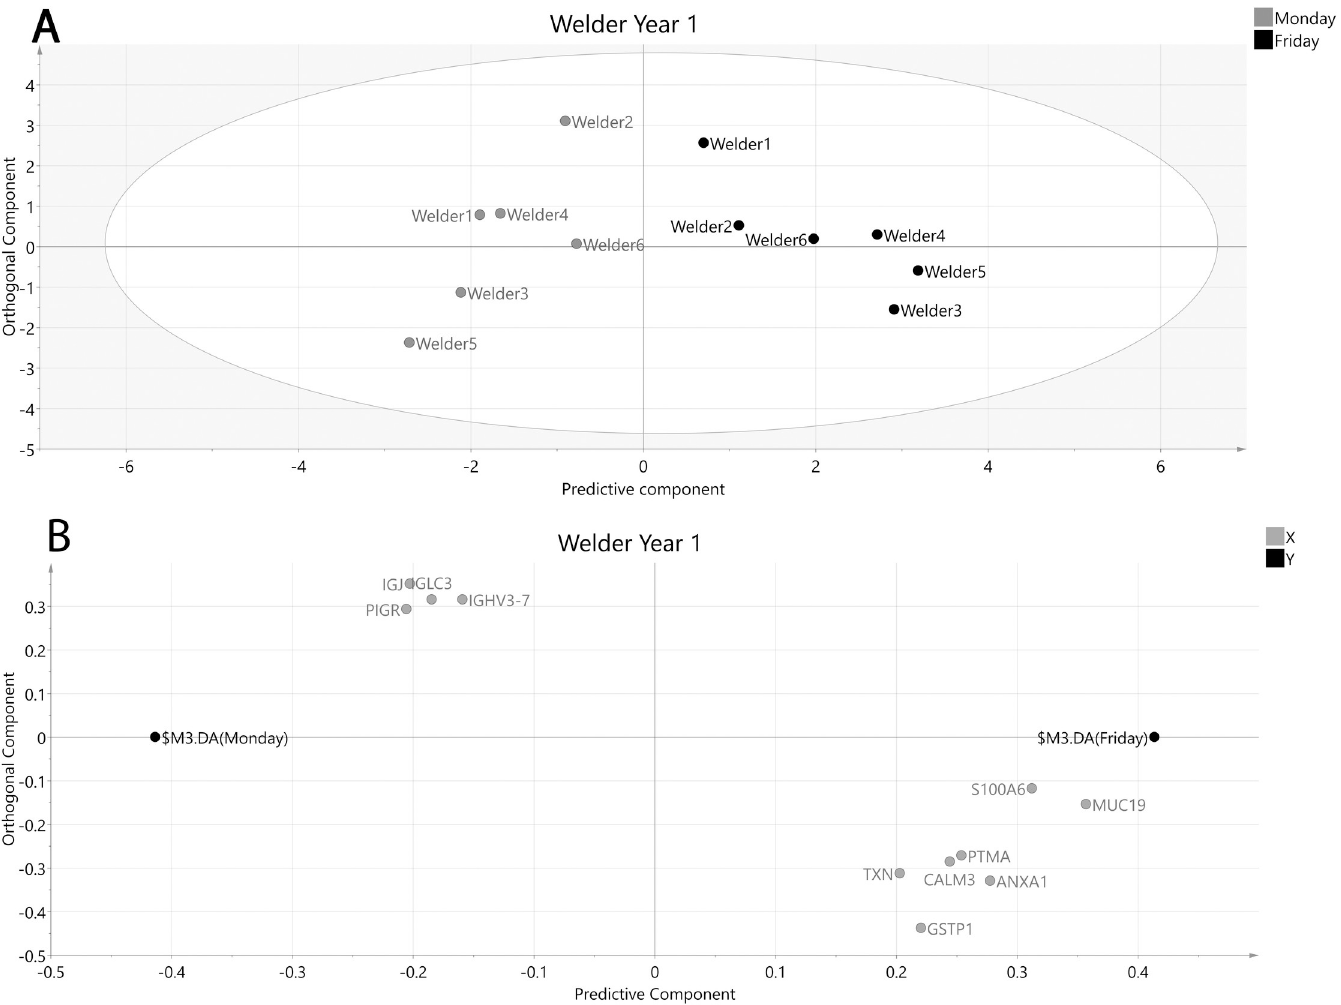
Fig 4. OPLS-DA model of welders year 1 after selecting proteins with VIP values � 1.2 and VIP values > standard error (SE). A: Score plot of participating welders at the beginning and end of the week. The x-axis depicts the predictive component most important for separating samples collected Monday (grey circles) vs Friday (black circles) while the y-axis represent the orthogonal component showing in-group variation. R2 = 0.84, Q2 = 0.20, p > 0.05. B: Loading plot showing the underlying protein separation (X-variables, grey circles) in relation to sampling time point (Y-variables, black circles). ANXA1—Annexin A1, CALM3—Calmodulin-3, GSTP1— Glutathione S-transferase P, IGHV3-7—Immunoglobulin heavy variable 3–7, IGJ—Immunoglobulin J chain, IGLC3—Immunoglobulin lambda constant 3, MUC19— Mucin-19, PIGR—Polymeric immunoglobulin receptor, PTMA—Prothymosin alpha, S100A6—Protein S100-A6, TXN–Thioredoxin.